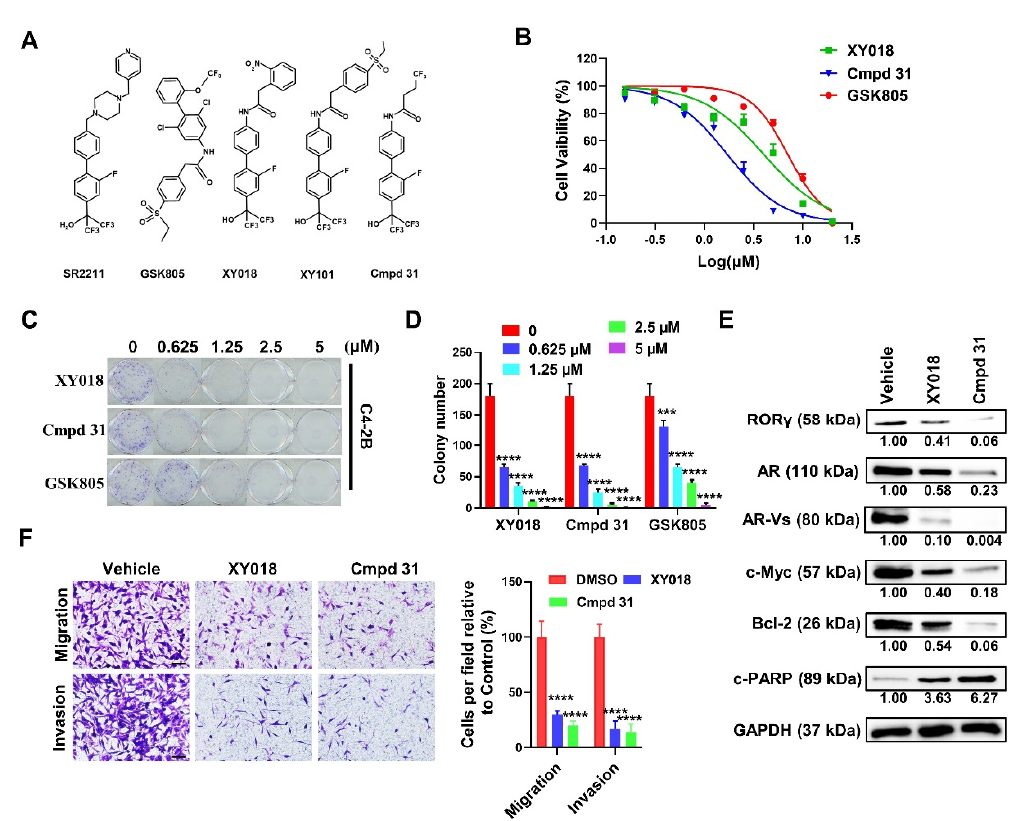
Figure 1. ROR γ antagonists potently inhibit CRPC cell proliferation, migration and invasion. ( A ) Chemical structures of the ROR γ antagonist compounds. ( B ) C4 − 2B cells seeded to 96 well plates were treated with indicated compounds for 96 h before cell viability was measured. ( C − D ) C4-2B cells were seeded to 6-well plates at 500/well and treated with different doses of indicated compounds for 2 weeks. The cell colonies were then stained and counted. ( E ) C4 − 2B cells were treated with 5 μ M of indicated compounds for 72 h before processed for Western blotting. Density of each band was measured by ImageJ software and normalized with that of GAPDH. Data were presented as fold changes relative to the density of vehicle. ( F ) C4 − 2B cells were treated with 5 μ M of XY018 or Cmpd 31 for 48 h before being subjected to migration and invasion assays. After incubation for 24 h (for migration) or 48 h (for invasion), migrated or invaded cells were fixed and stained. Scale bar, 200 μ m. Cells were counted under microscopy for 5 random fields. Results are presented as mean ± SD. *** p < 0.001, **** p < 0.0001.